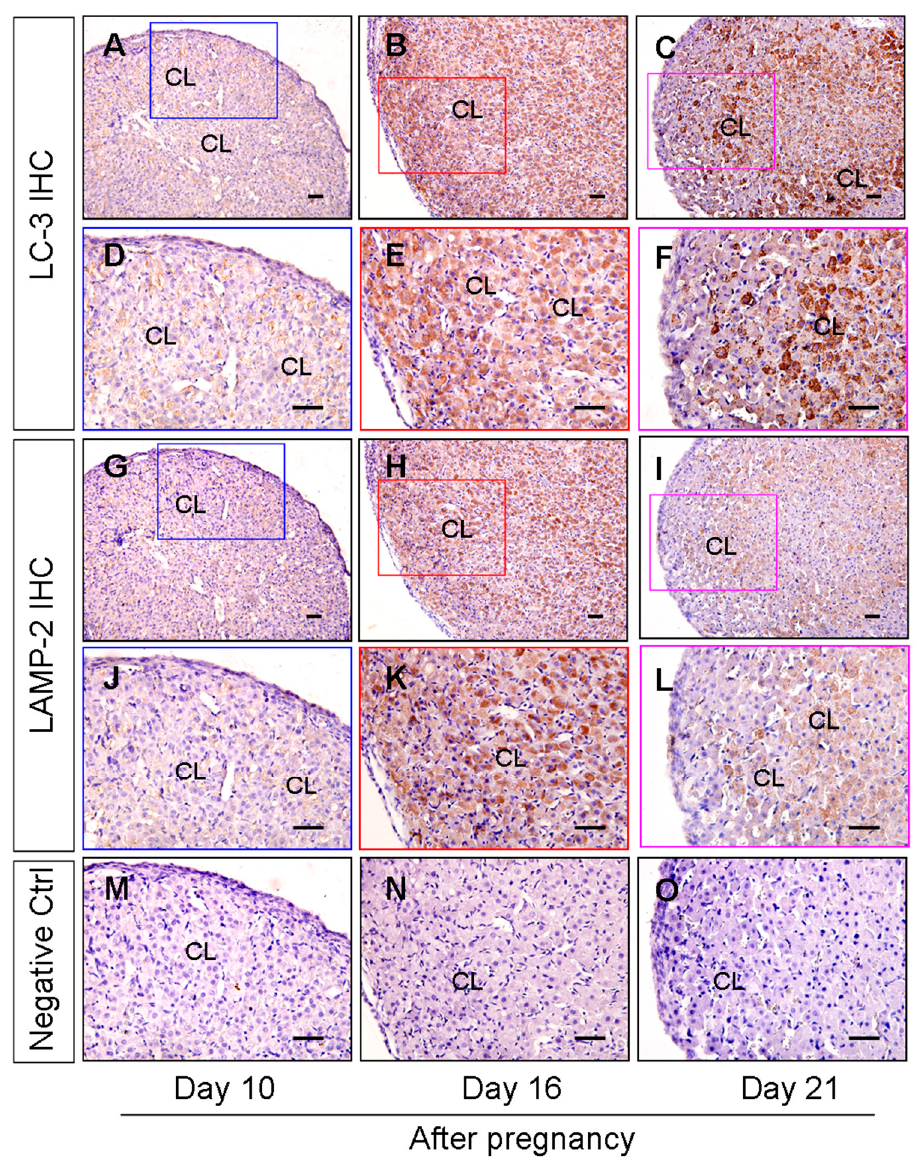
Figure 1. Expression and localization of LC-3 and LAMP-2 during the luteal development in the ovaries of pregnant rats. LC-3 ( A – F ) and LAMP-2 ( G – L ) immunohistochemical signals appear brown, and the counterstaining background appears blue in color. Negative controls remained unstained, lacking a primary antibody instead of a serum ( M – O ). ( A , D , G , J , M ) are results on day 10 after pregnancy; ( B , E , H , K , N ) are results on day 16 after pregnancy; ( C , F , I , L , O ) are results on day 21 after pregnancy. CL: corpus luteum. Scale bar = 100 μ m.